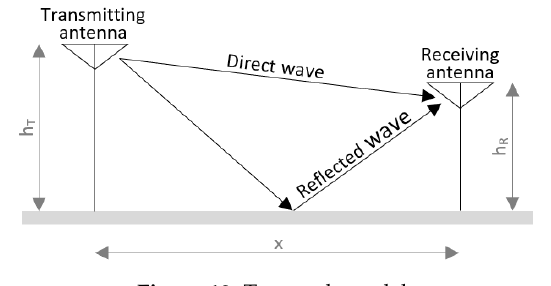
Figure 10. Two-path